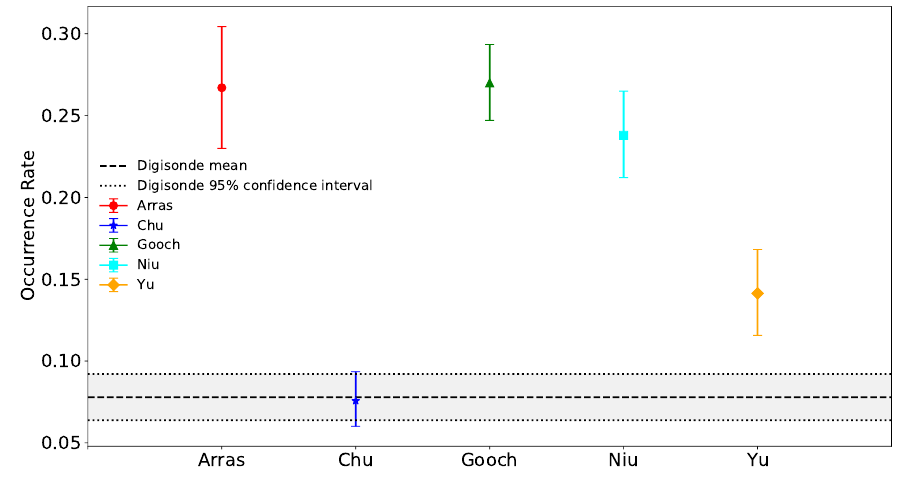
Figure 7. Same as Figure 4, but for fbEs ≥ 3